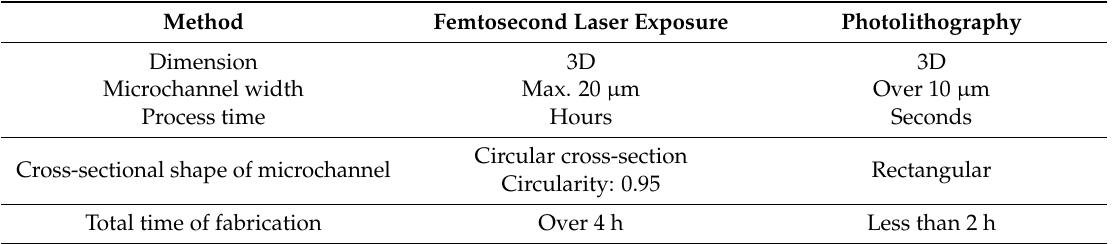
Table 1. Comparison between the femtosecond laser and photolithography fabrication